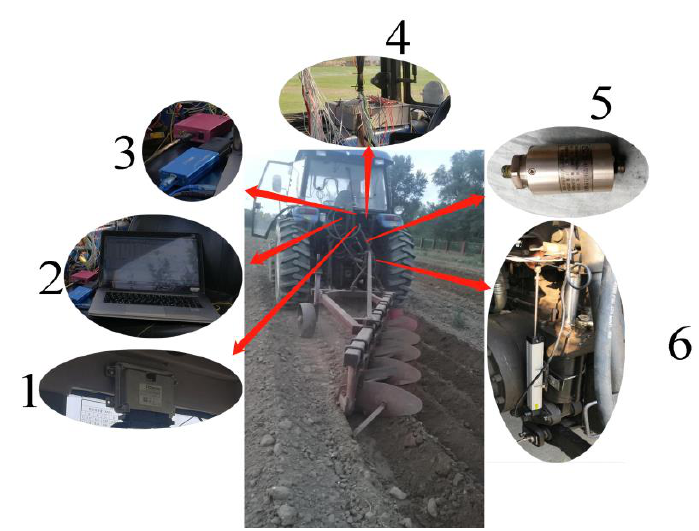
Figure 12. Pressure control experimental platform for the tractor. ( 1 ) Pressure controller; ( 2 ) Host computer; ( 3 ) CAN card; ( 4 ) Power supply; ( 5 ) Pressure sensor; ( 6 ) Displacement sensor.